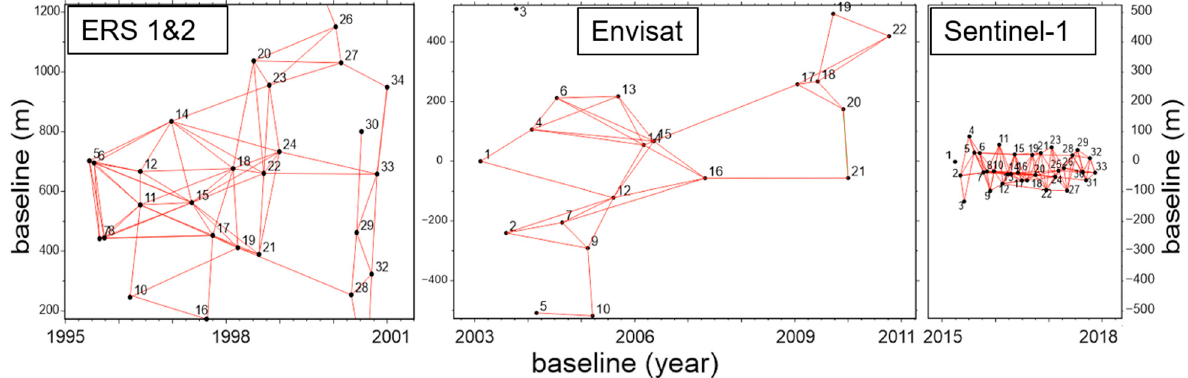
Figure 3. Interferometric cloud of the three constellations ERS, Envisat, Sentinel-1. The numbers in the graphs correspond to the radar images (numbered by its acquisition date) and the connection lines to the interferometric pair. The temporal and spatial baseline improvement provided by Sentinel-1 is remarkable.